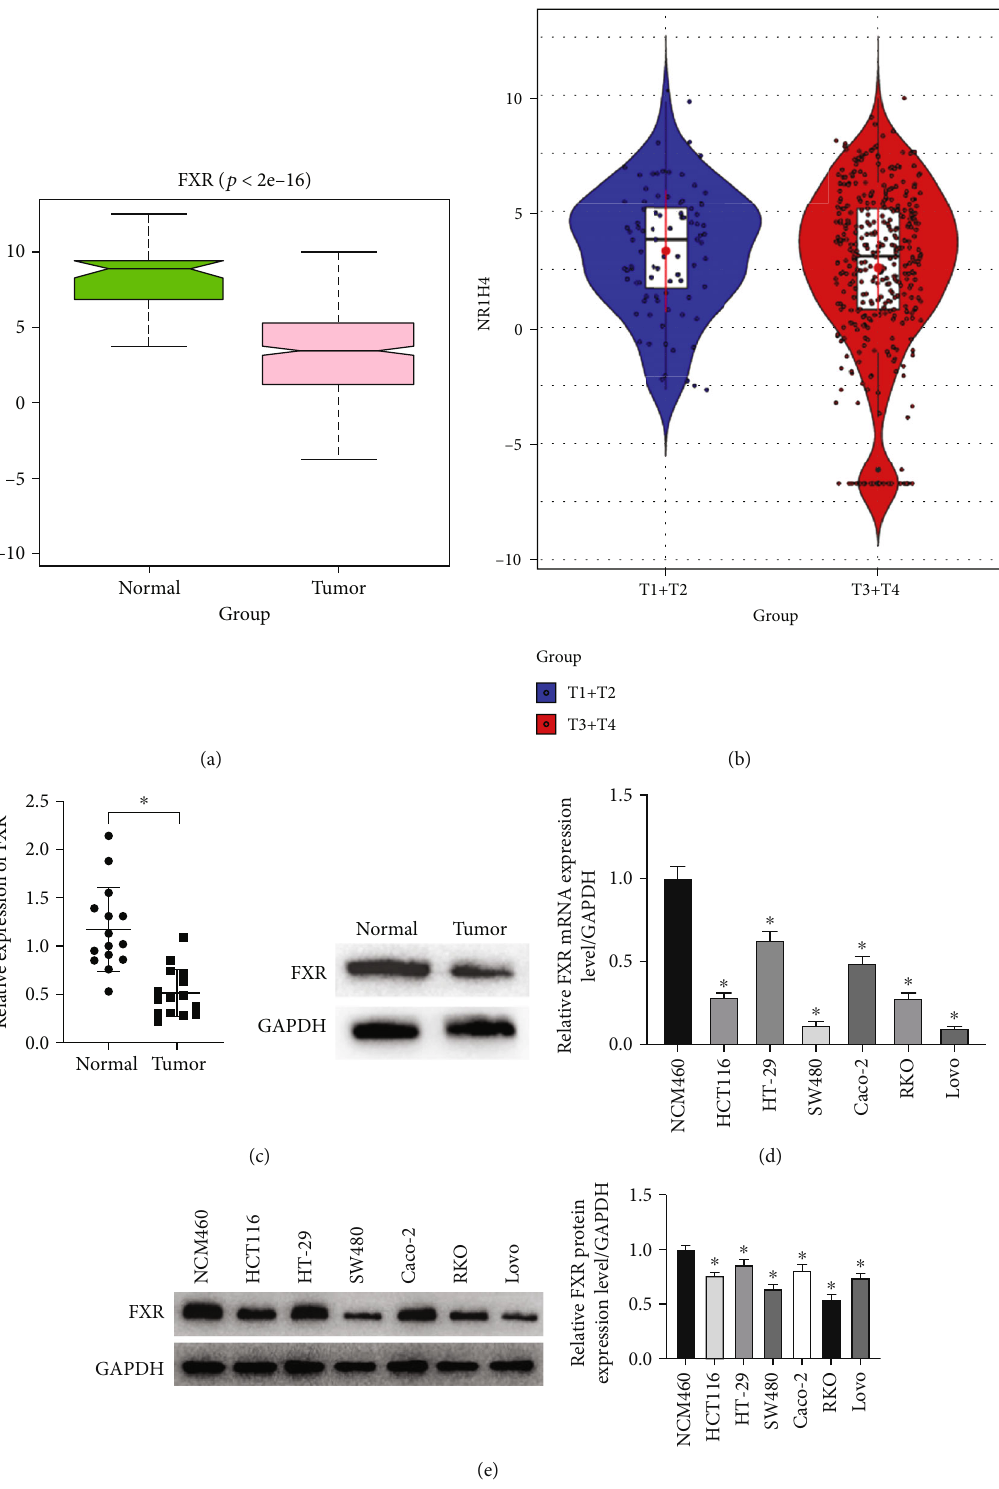
Figure 1: FXR is lowly expressed in colon cancer cell lines. (a). According to TCGA database, the expression of FXR in colon cancer tissues was signi fi cantly reduced compared to normal tissues. The green box shows the normal sample and the pink box shows the tumor sample. (b). According to TCGA database, the expression of FXR in T3+T4 colon cancer patients was signi fi cantly reduced compared to T1+T2 patients. The blue violin shows the T1+T2 patients, and the red violin shows the T3+T4 patients. (c). qRT-PCR and Western blot were employed to evaluate the mRNA and protein levels of FXR in colon cancer patients. (d and e). qRT-PCR and Western blot were employed to evaluate the mRNA and protein levels of FXR in colon cancer cell lines. ( ∗ denotes P < 0 : 05